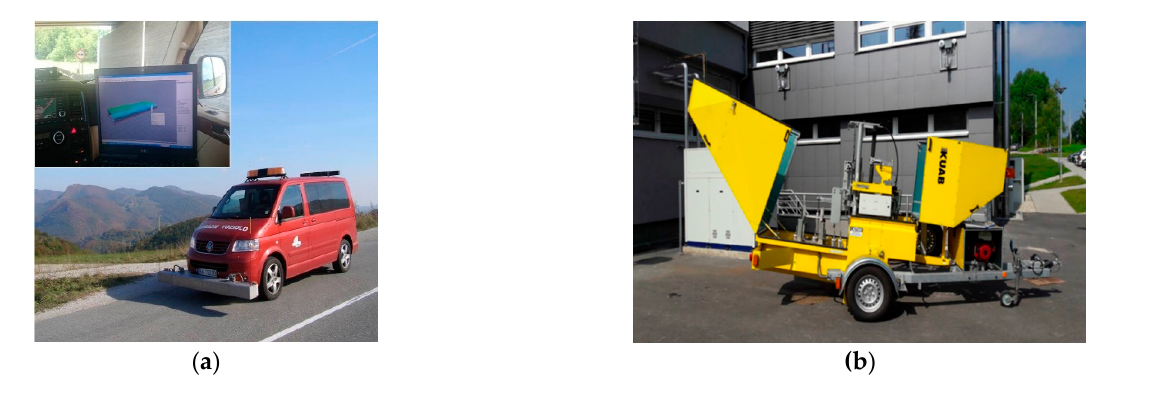
Figure 4. Profilegraph GE ( a ); Falling weight deflectometer KUAB 50 ( b ).